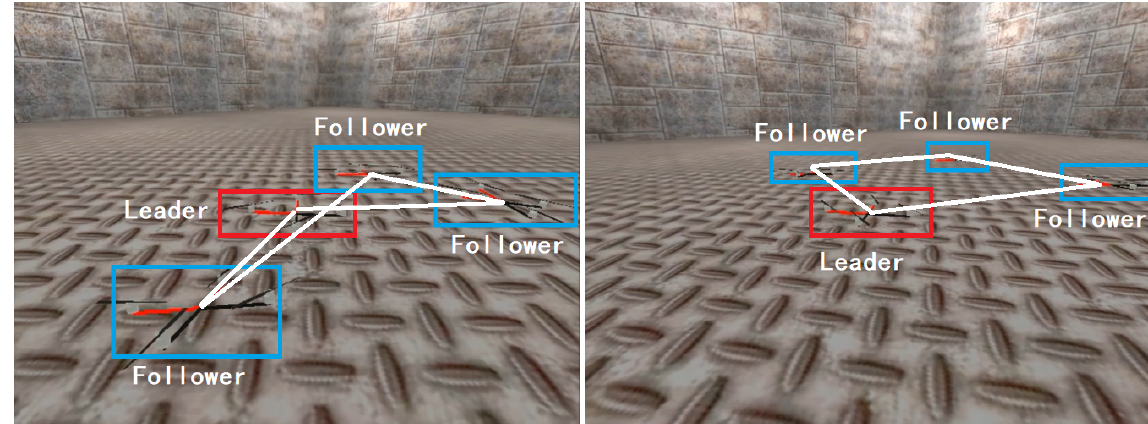
Figure 8. Four quadrotors with rectangle formation pattern, tracking a circular trajectory, using formation control without high-order feedforwards ( left ), and the proposed formation control ( right ).